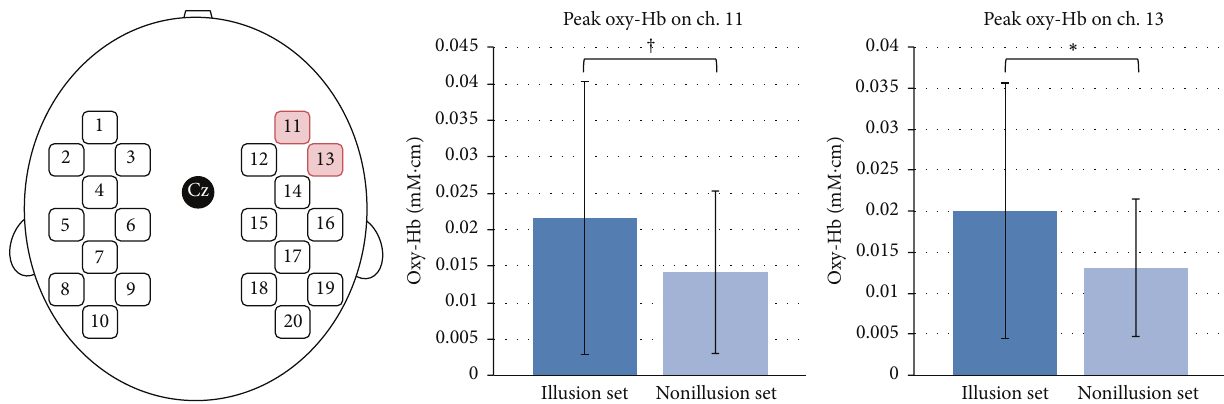
Figure 4: Significant activation of illusion set compared with nonillusion set. The activation of oxy-Hb on ch. 13 (right motor related areas) was significantly different between two sets. In addition, the activation of oxy-Hb on ch. 11 (right frontal cortex) in illusion set was also slightly higher than nonillusion set. ∗ 𝑝 < .05 and † 𝑝 < .10 .